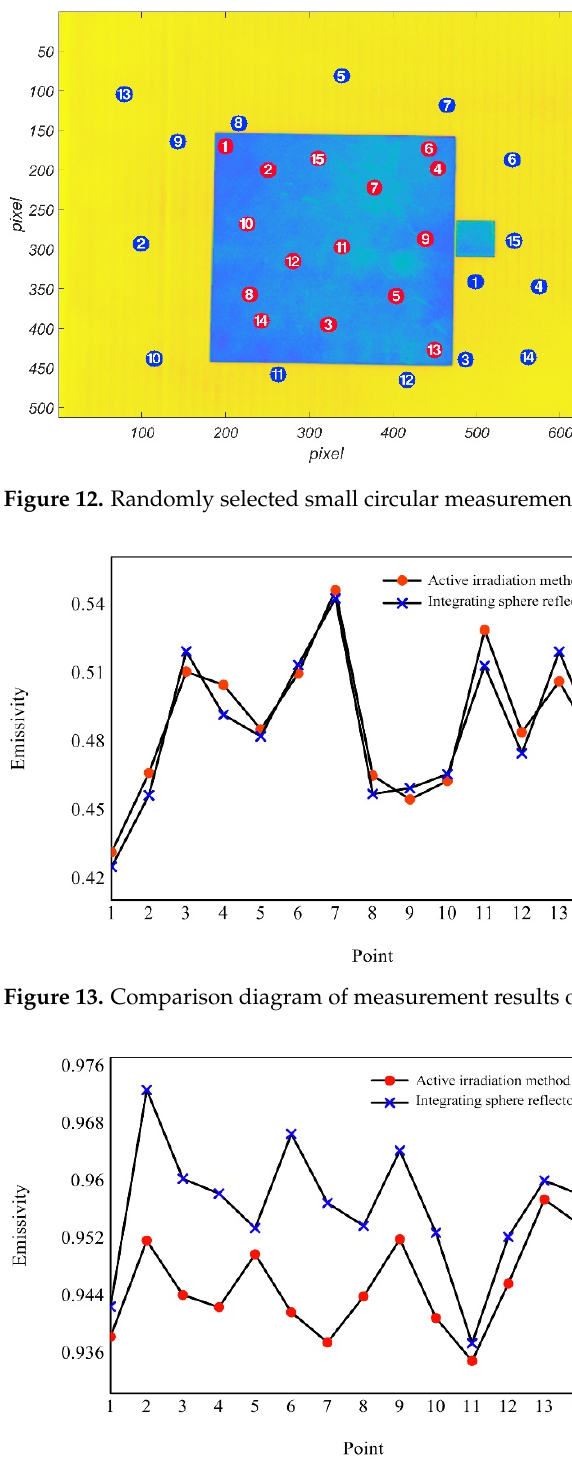
Figure 14. Comparison diagram of measurement results of black background plate area.